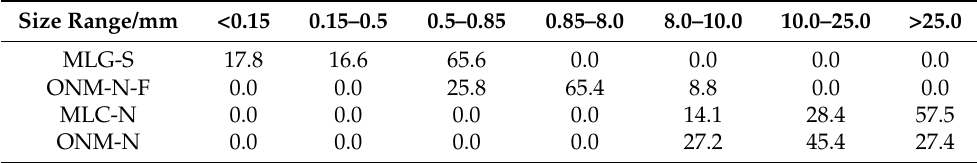
Table 1. Size distribution of raw materials used in the tests